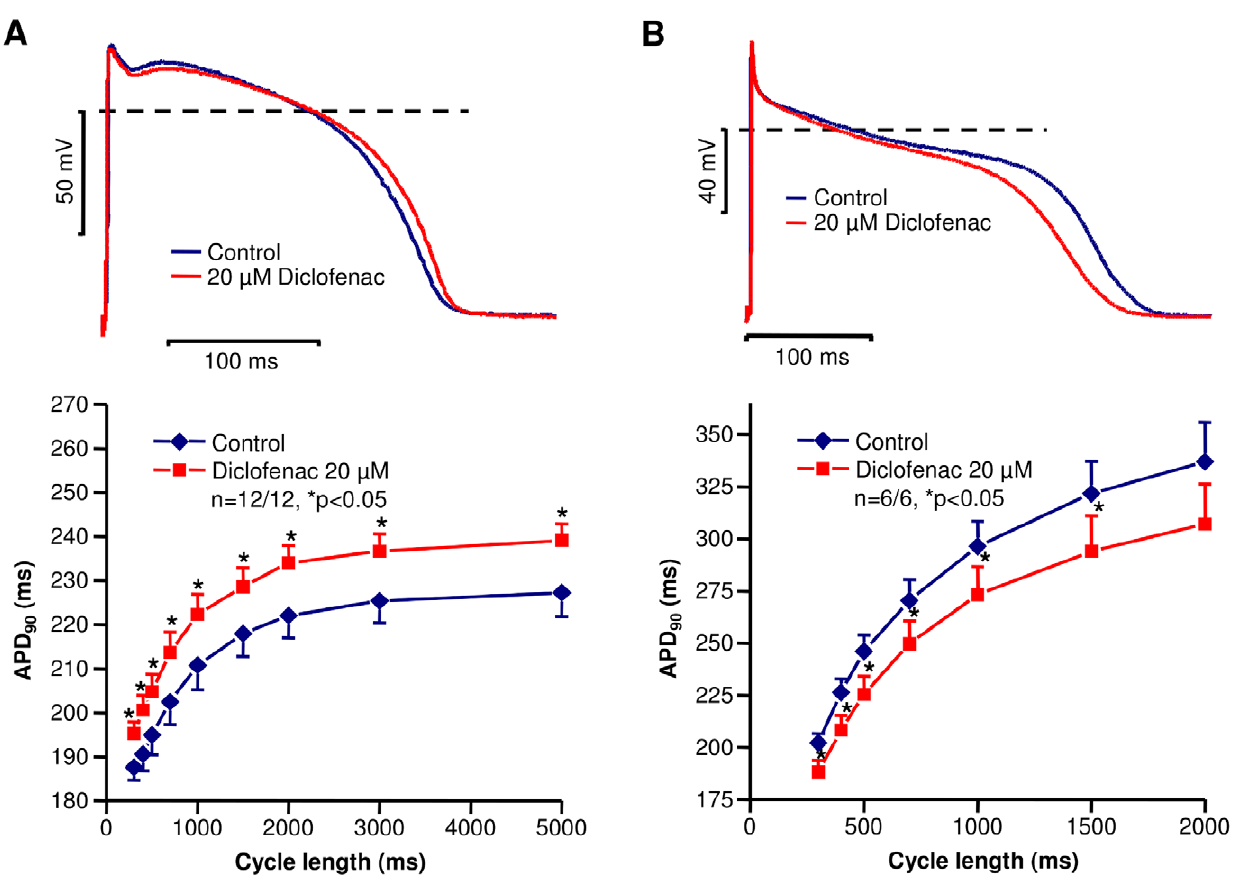
Figure 1. Effect of diclofenac on action potentials in canine right ventricular muscle preparations and in Purkinje fibers. Representative superimposed records ( top ) demonstrating the effect of 20 m M diclofenac on action potential configuration at 1 s stimulation cycle length ( A , right ventricular muscle; B , Purkinje fiber). Cycle length dependent changes in action potential duration (APD 90 ) measured under control conditions and in the presence of 20 m M diclofenac ( bottom ) in canine right ventricular muscle preparations ( A ) and in Purkinje fibers ( B ). Data are expressed as mean 6 SEM, n=number of measurements/number of animals.